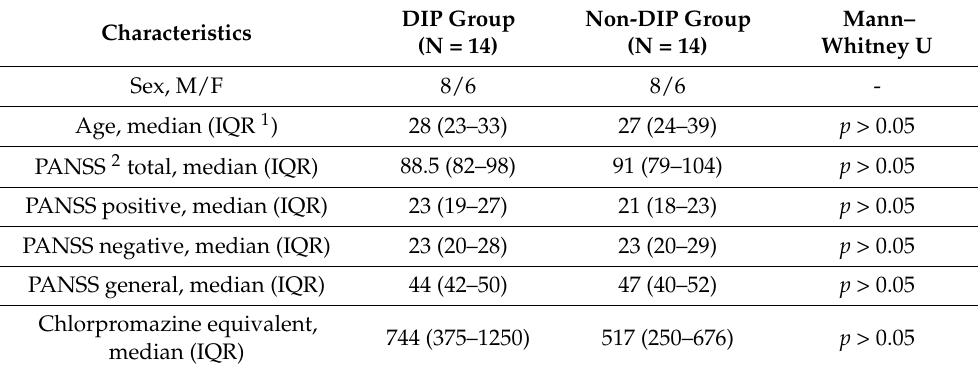
Table 1. Demographic and clinical characteristics of schizophrenic patients with and without